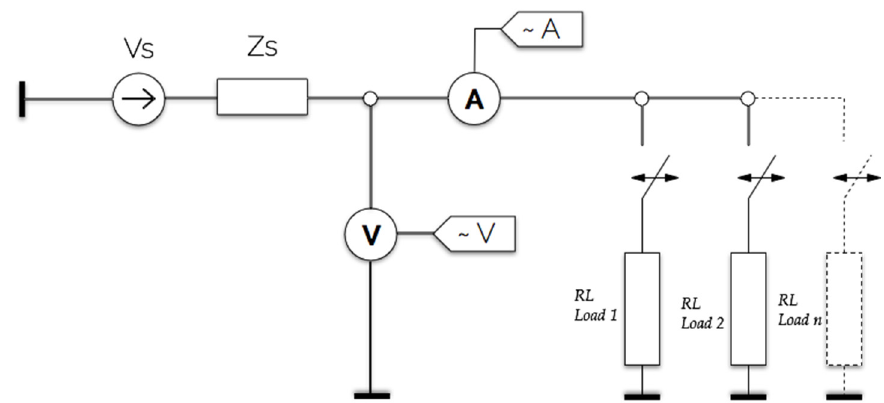
Figure 2. Single-phase power network.